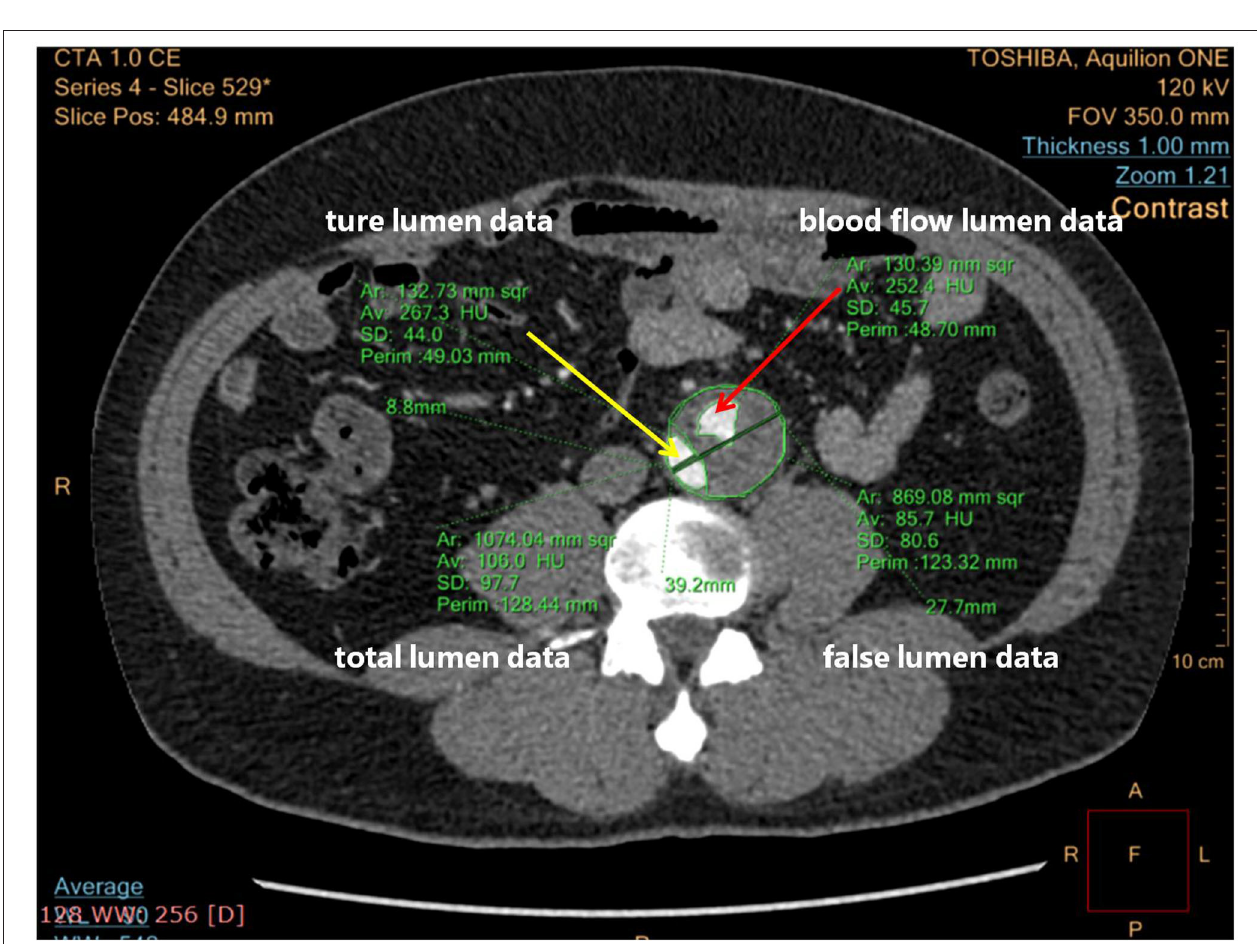
FIGURE 3 | Computed tomographic angiography (CTA) cross-section measuring details blood flow lumen. The yellow arrow points to the true lumen; the red arrow points to the blood flow lumen.